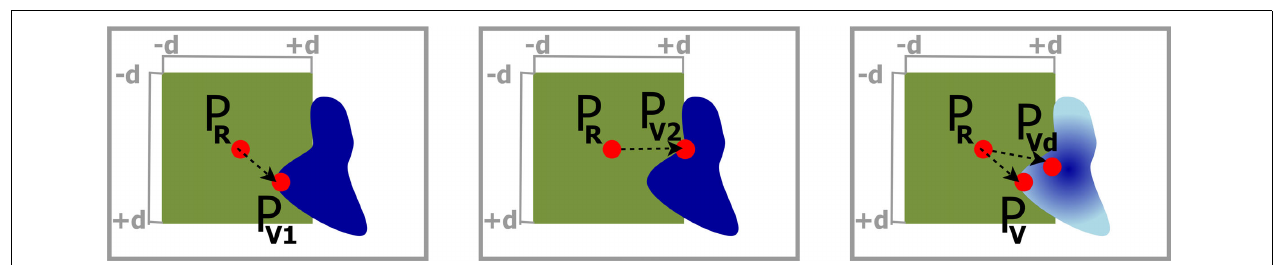
A darker color in the VOI depicts a higher depth value. P V is the closest texel to P R and is used to calculate the distance to the VOI, but P Vd has the highest depth value in distance d around P R , and is utilized as depth